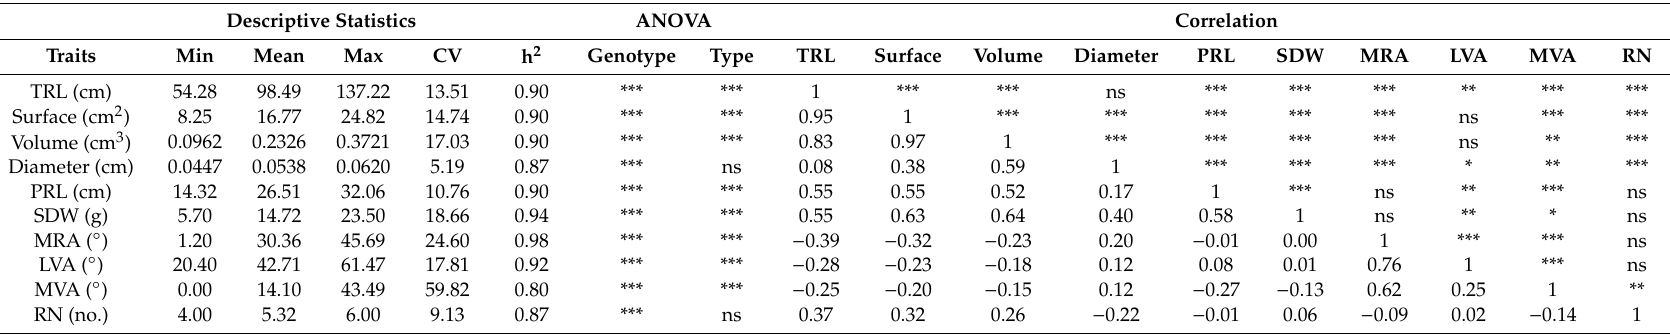
*, **, ***: sources of variation in the analyses of variance or correlation coe ffi cients significant at p < 0.05, 0.01, and 0.001, respectively. TRL: Total root length, Surface: total root surface area, Volume: Total root volume, Diameter: mean root diameter, PRL: Primary root length, SDW: Shoot dry weight, MRA: Mean root angle, LVA: Least vertical angle, MVA: Maximum vertical angle, RN: Root